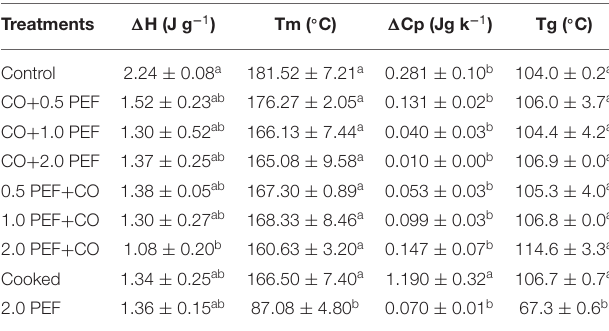
TABLE 3 | Enthalpy, fusion temperature, specific heat, and glass transition temperature corresponding to differential scanning calorimetry (DSC) thermograms of pretreated freeze-dried Chilean abalone samples.